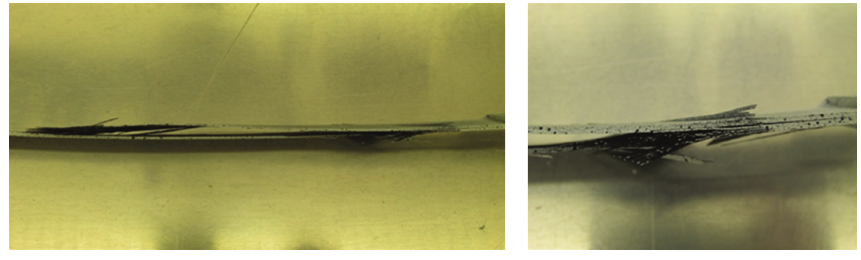
Figure 6: Representative close-up images of side surface damage to the CNF modified samples (a) and of the control images (b). The CNF modified samples show multiple layer damage representing localized failure occurring through the cross-section of the samples primarily. The control samples show cross-sectional initial failure on a surface, followed by delamination through the midplane and final cross-sectional failure on the opposite surface.